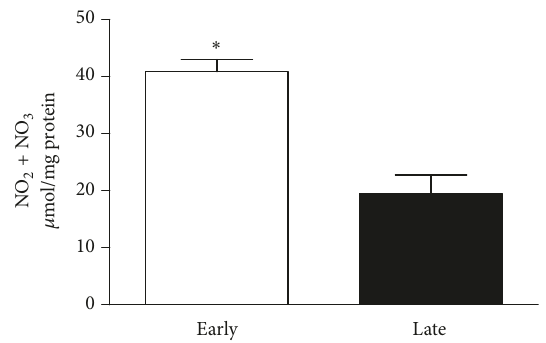
Figure 2: Estrogen-induced production of nitric oxide (NO) in GSMC from early- and late-pregnant rats. Total NO metabolites (nitrate + nitrite) were measured as indicators for nitric oxide (NO) levels. Treatment of GSMC with estrogen (E2) signifi- cantly increased NO levels in GSMC. Values shown are repre- sentative of three independent experiments performed in tripli- cate. Samples were collected from 6 early-pregnant and 7 late- pregnant rats. ∗ measurements in early-pregnant rats are signifi- cantly different ( P < 0.05) from corresponding measurements in late-pregnant